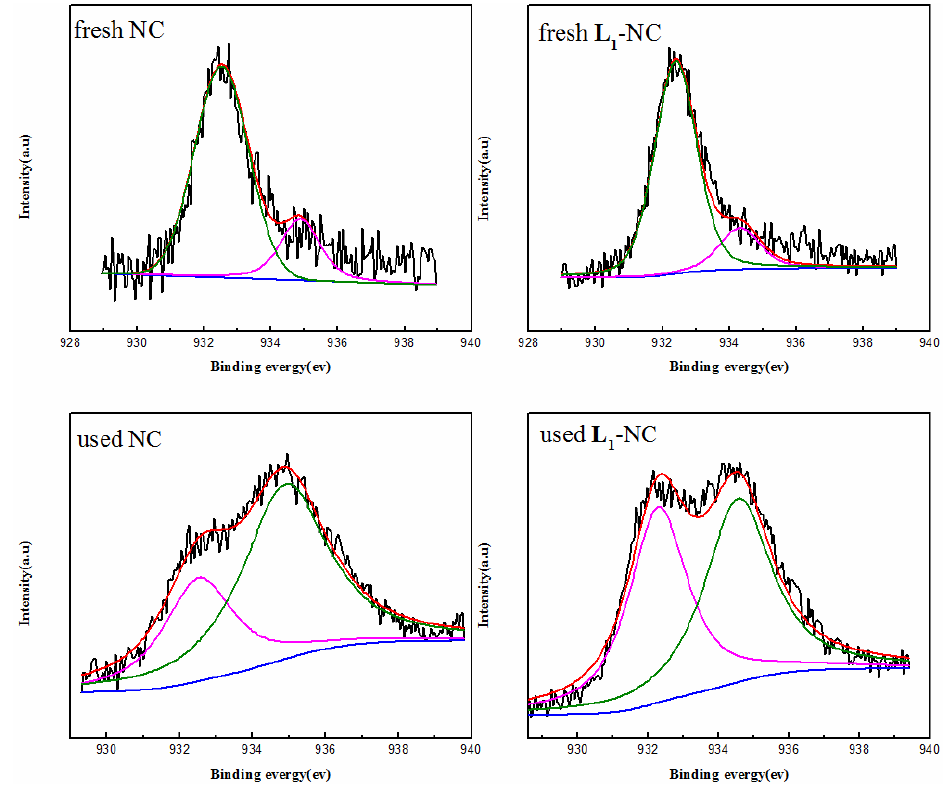
Figure 9. High-resolution XPS spectra of fresh NC, L 1 - NC and used NC, L 1 - NC. Table 4. Relative content and binding energy of Cu + and Cu 2+ in fresh catalyst.